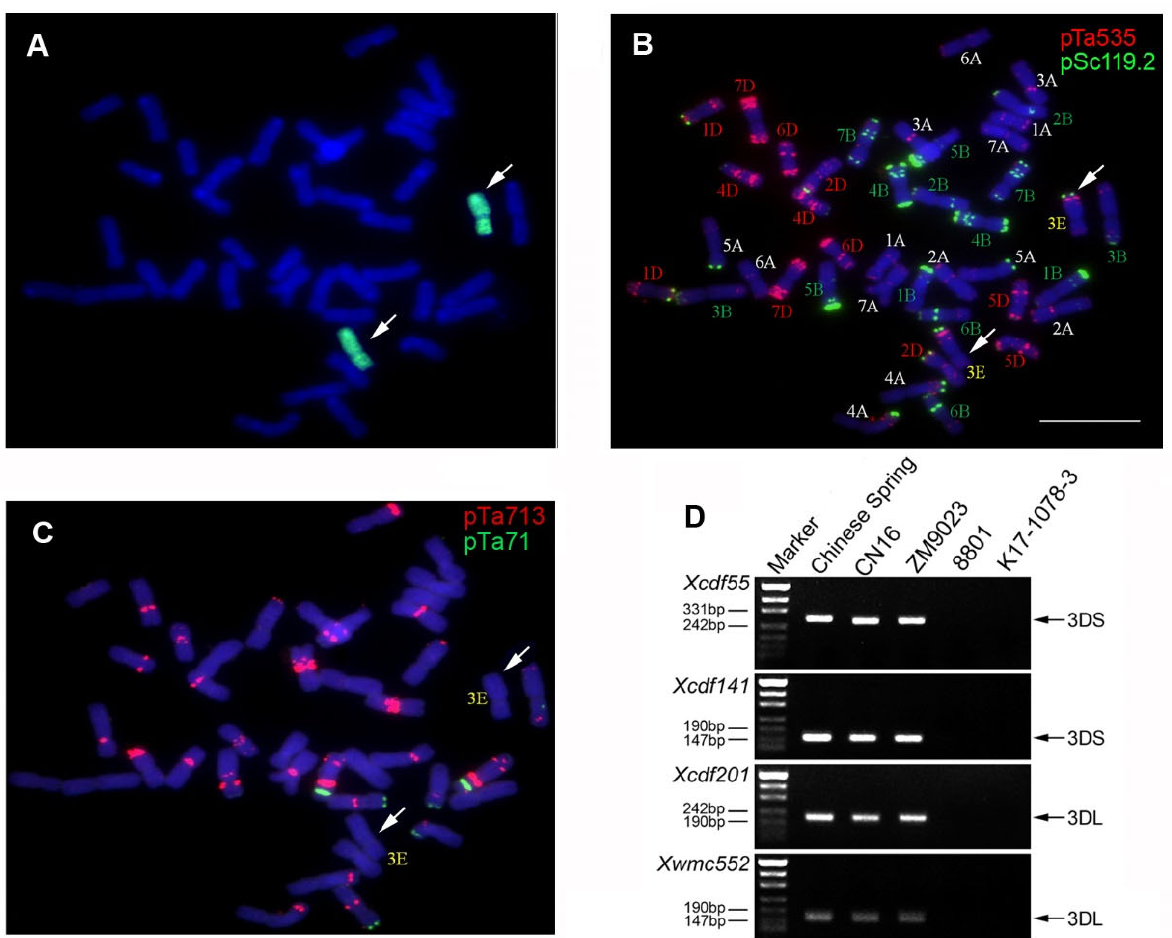
Figure 1. GISH, FISH, and molecular identification of the wheat substitution line K17-1078-3. The probes used for in situ hybridization were genomic DNA of tetraploid Th. elongatum ( A ); pSc119.2 and pTa535 ( B ); pTa713 and pTa71 ( C ). The white arrows indicated 3E chromosomes. The black arrows showed the diagnostic amplification products of SSR markers of Xcfd55, Xcfd141, Xcfd201, and Xwmc552 ( D ). Scale bar: 10 µm.